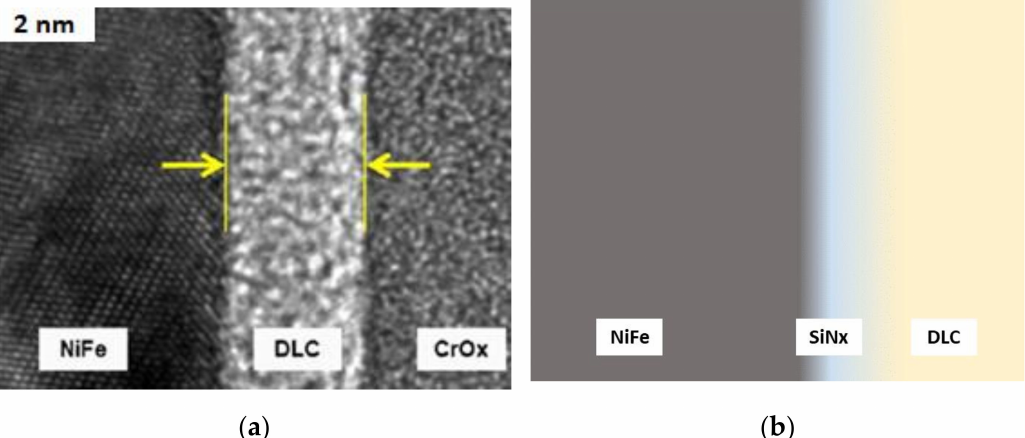
Figure 3. TEM image showing the DLC film sandwiched by the NiFe substrate and a Cr 2 O 3 added layer that protects the DLC film from the Focused Ion Beam (FIB) milling process during TEM lamellae preparation ( a ). A schematic drawing of the as-deposited SiN x /DLC layer stack on NiFe is shown in ( b